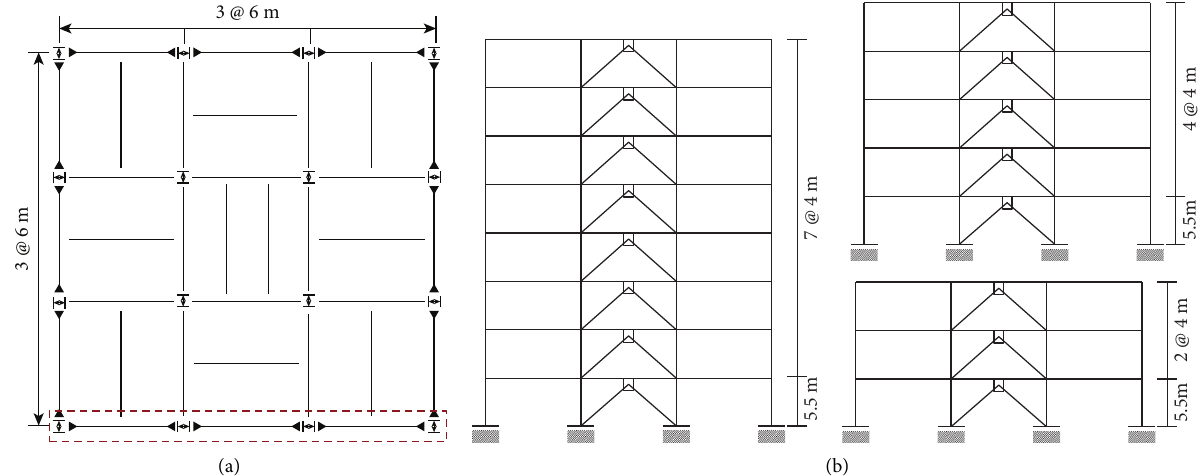
Figure 1: An analysis of model structures: (a) structural plans; (b) elevations of structures that include dampers [34].